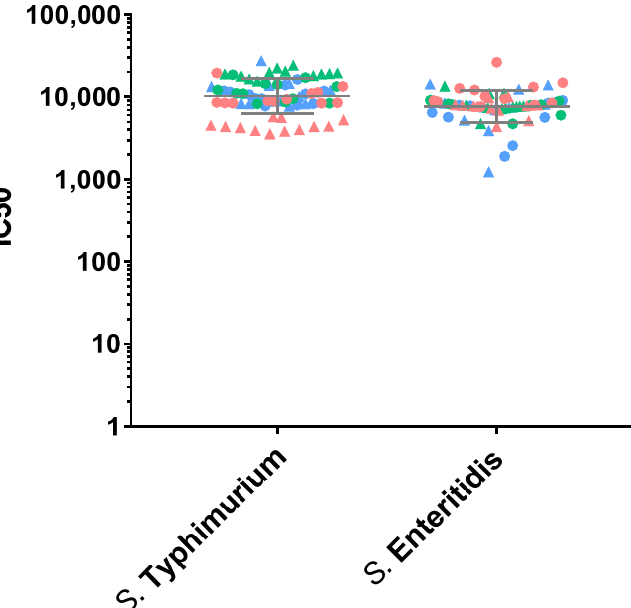
Figure 1. SBA titers (IC50) obtained from the precision test, performed by probing standard sera in 12 independent replicates, on 3 different days and by two operators against the S . Typhimurium D23580 and S . Enteritidis CMCC4314 strains. Single repeats of each operator are represented by circles (for operator 1) and triangles (for operator 2), and repeats on different days are shown in red for day 1, green for day 2, and blue for day 3. Geometric means and geometric standard deviations from all repeats are represented by the grey lines for each of the strains.